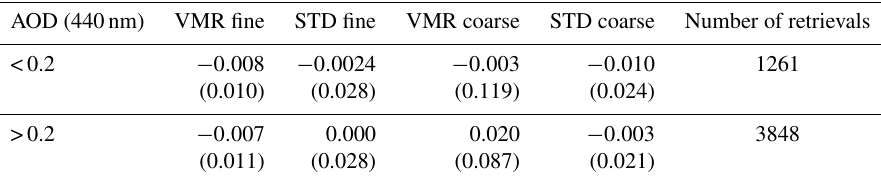
Table 3. Statistics, average values and standard deviations (in parentheses) of the difference in volume median radius (VMR) in microns and width of particle size distribution (STD) retrievals of V2 and V3 and for the Mezaira site for almucantar retrievals with AOD (440)>0.2. The difference is defined as V3 − V2.